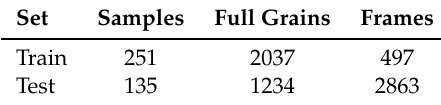
Table 3. Characteristics of the datasets established to adjust and test the